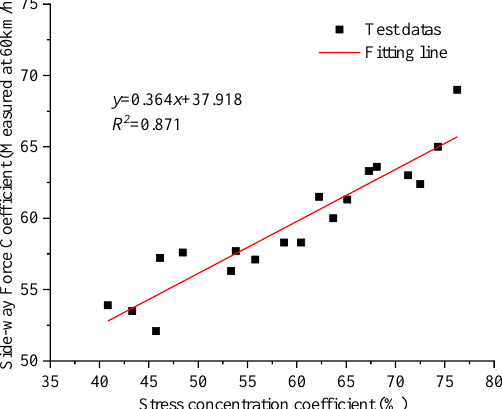
Figure 18. Relationship between stress concentration and SFC.